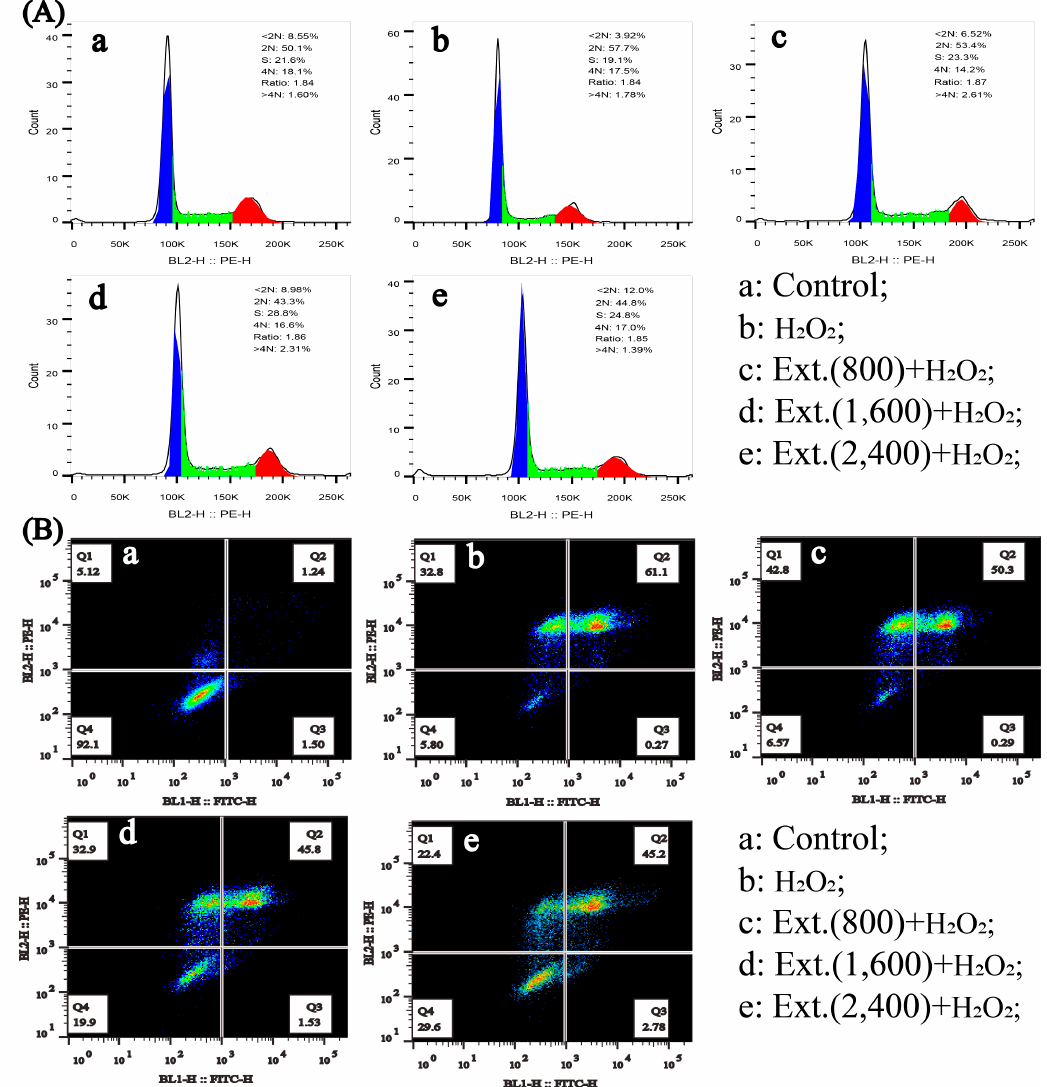
Figure 2. Chrysanthemum extract inhibited H 2 O 2 -induced cell cycle arrest and non-apoptotic cell death. L-O2 cell was pre-treated with different concentrations of chrysanthemum extract and treated with H 2 O 2 . ( A ) Cells were stained with PI and RNAse, then analyzed with a flow cytometer through the BL-2 channel. ( B ) Cells were stained with PI and annexin-V-FITC, then analyzed with a flow cytometer through the BL-1 and BL-2 channels. Ext.: chrysanthemum extract. Blue represents 2N (G0, G1 phase), green represents S phase, and red represents 4N (G2 phase).